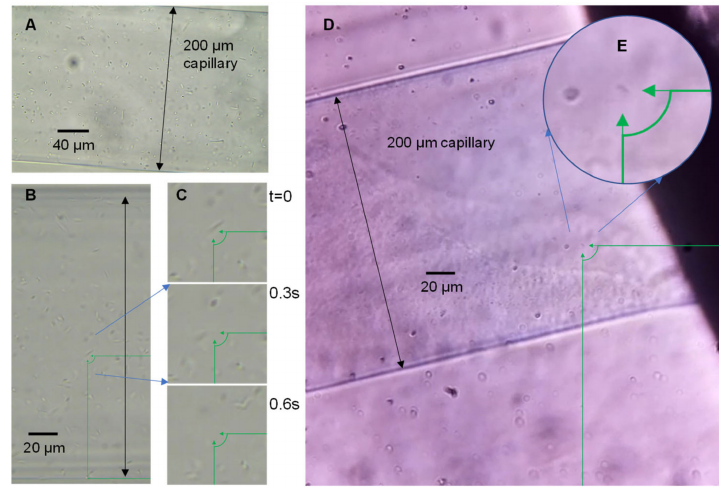
Figure 2. Comparison of conventional phase contrast microscopy (using 40X objective) with OpenFlexure 3D-printed digital microscope. Samples of P. aeruginosa are shown imaged using ( A – C ) conventional microscope compared with ( D , E ) OpenFlexure microscope. ( B , C ) show how the rapid movement of motile bacteria are clearly visible when the micrograph is enlarged. Although the OpenFlexure micrograph ( D ) has lower magnification, and bacterial cells are still clearly visible ( E ) but are smaller and with less intense contrast than the conventional